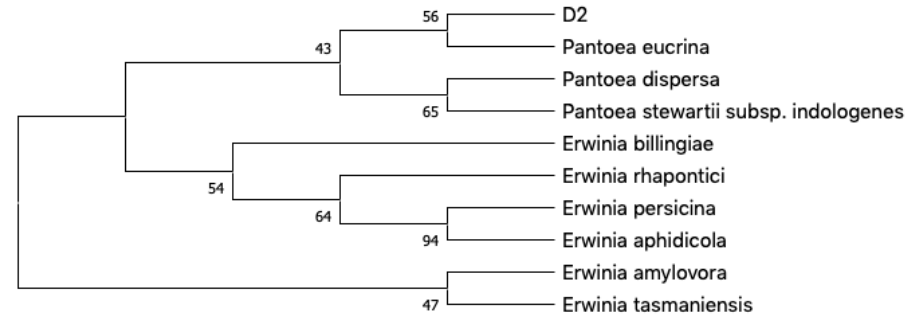
Figure 1. Phylogenetic neighbor-joining (NJ) tree generated with MEGAX based on 16S rRNA gene sequences from D2 and the most related species according to matching entries on BLAST. Next to the branches are shown the percentage of replicate trees in which the associated taxa clustered together in the bootstrap test (1000 resamples).